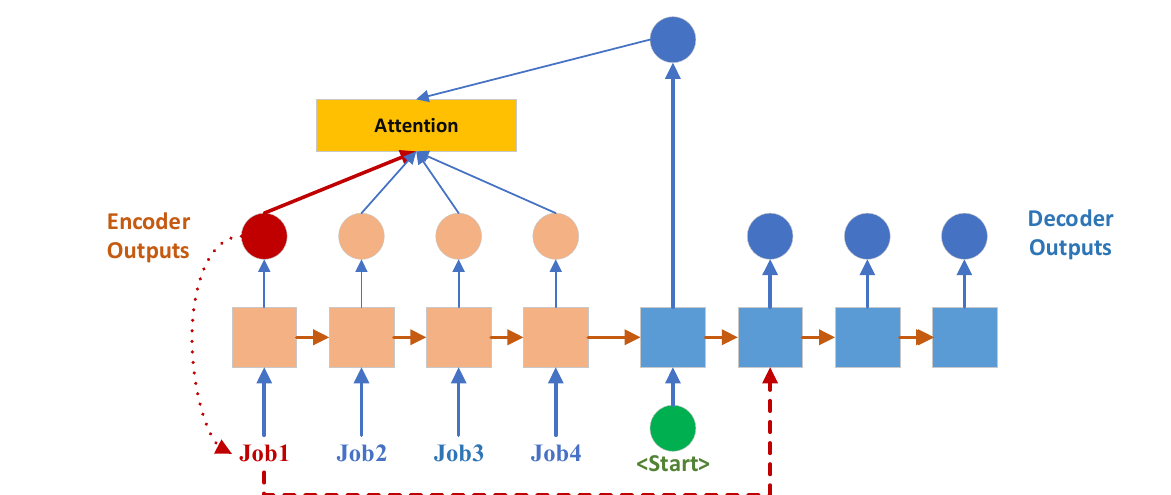
LSTM Decoder Figure 2. The sequence ‐ to ‐ sequence network structure. The encoder ‐ decoder network based on the attention mechanism has performed well on the sequence ‐ to ‐ sequence problem. However, directly applying it to solve the PFSP problem suffers from the following two issues. (4)